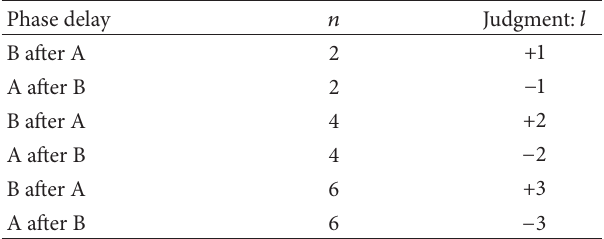
Table 2: Distinguishing